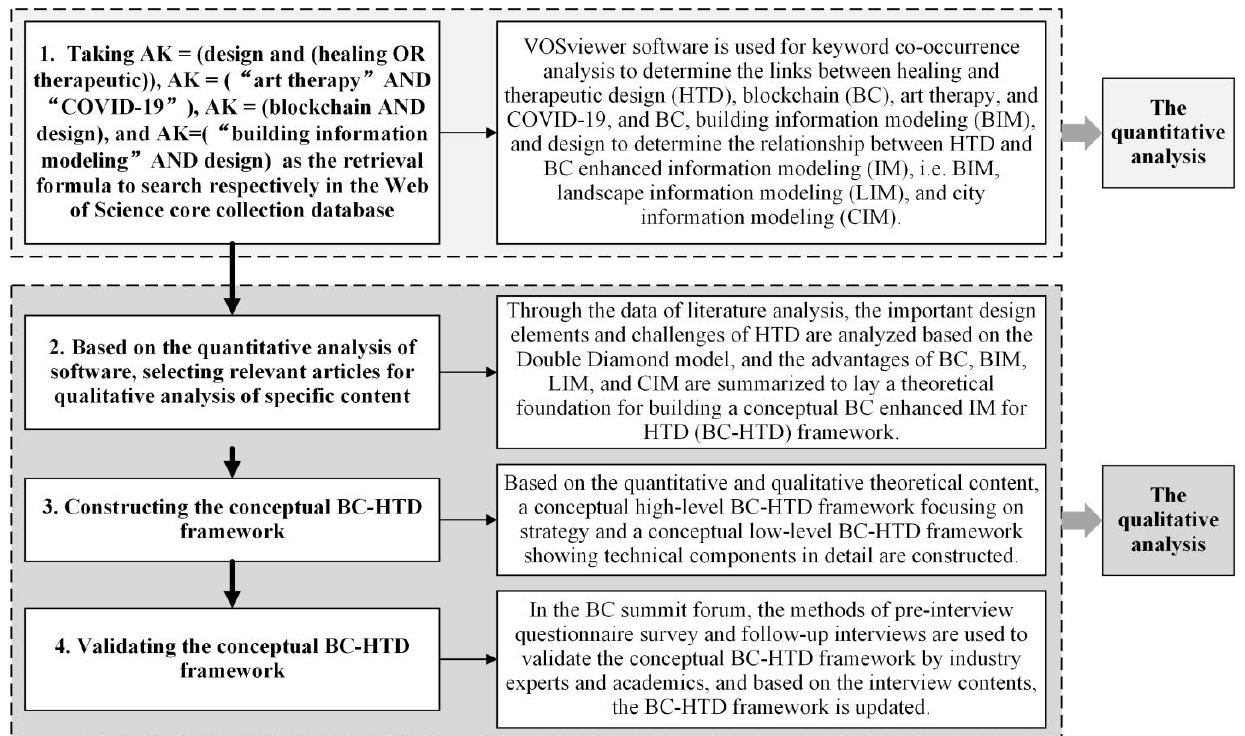
Figure 1. The flow chart of the research methodology.